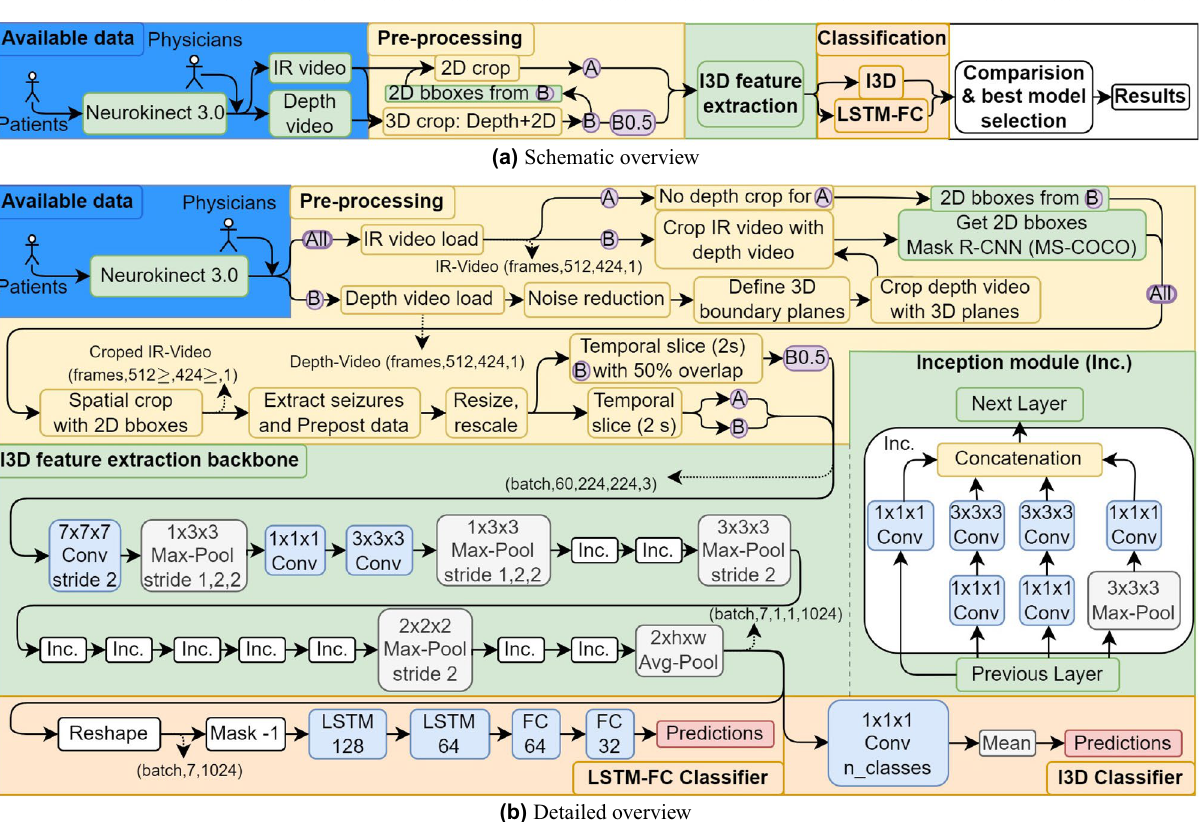
Figure 2. Examples of detection and crop, when the bed and the patient were properly detected, surrounding scenery removed, with enough space left to capture the full scale of seizures ( a , b 2D Mask R-CNN crop is more effective, c , d depth crop is more effective, dotted red line—detection box, straight red line—crop box).